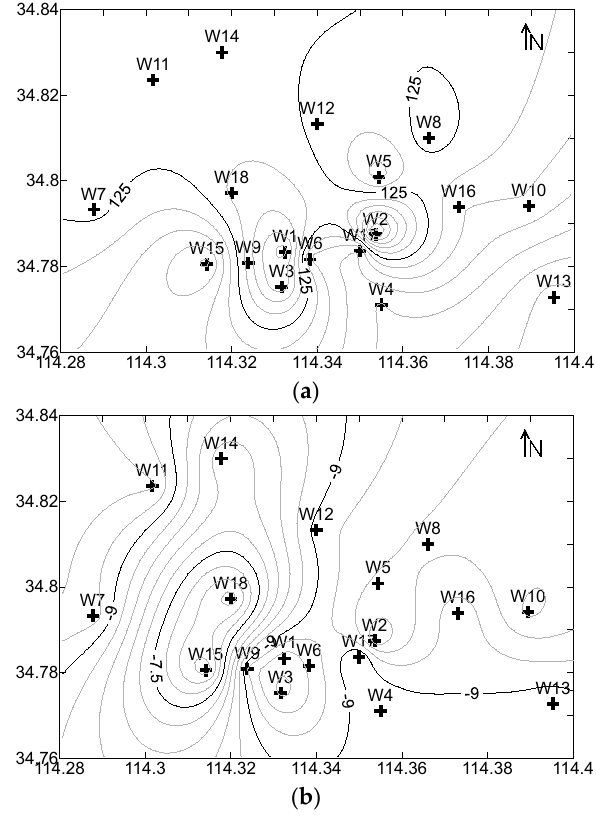
Figure 4. Spatial variations of DIC ( a ) and δ 13 C DIC ( b ) of deep geothermal water in Kaifeng.